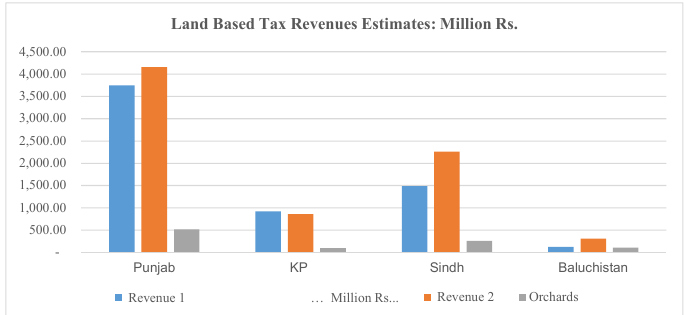
Fig. 2: Land Tax Revenues Estimates by Province: 2017-18; based on the authors calculations given in Table 3